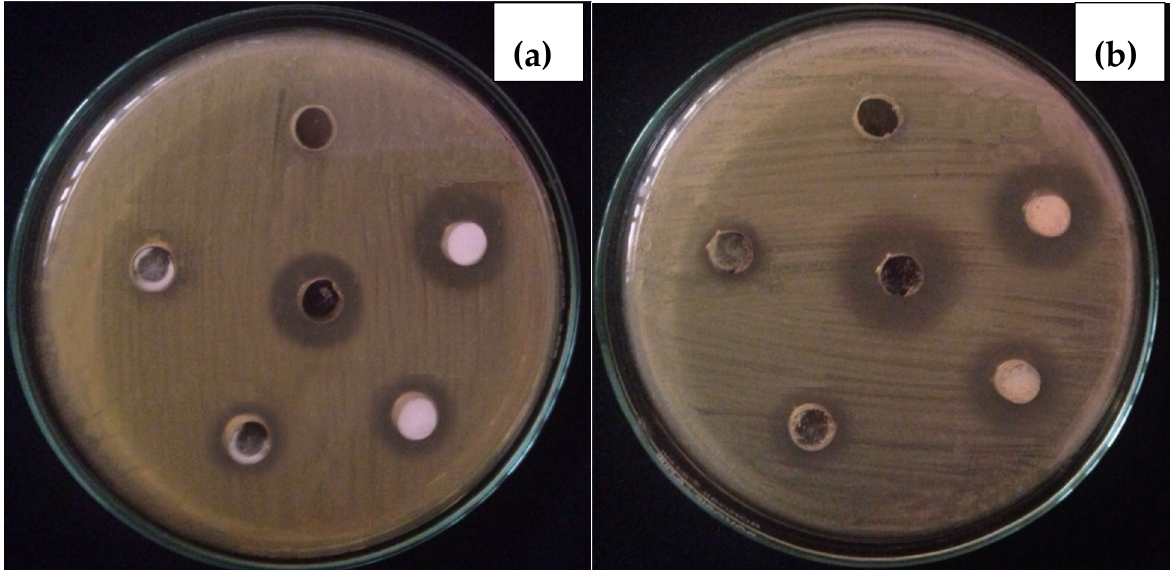
Figure 5. Experimental photographs of in-vitro activity of Fe 2 O 3 NPs against E. coli ( a ) and S. aureus ( b ).